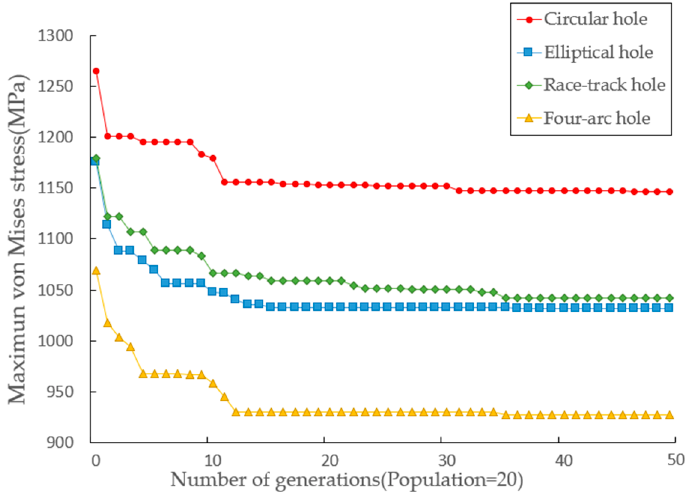
Figure 8. Convergence history of the optimization objectives (maximum von Mises stress) of the four different shapes of vent holes. Table 4. Details of the initial circular scheme, optimal circular scheme, optimal elliptical scheme, optimal race-track scheme, and optimal four-arc scheme.